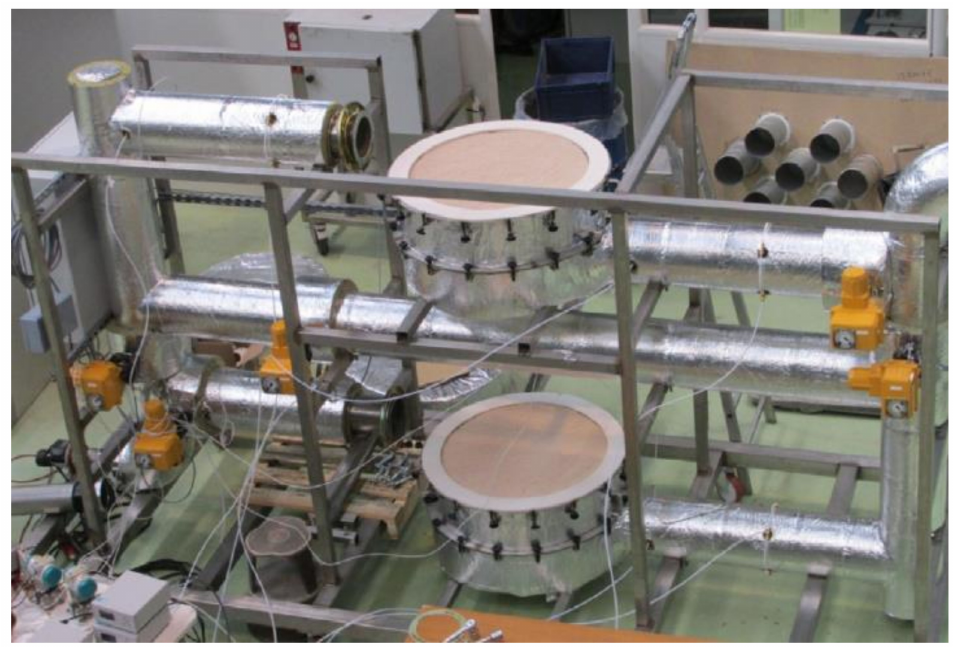
Figure 21. Developed sorption heat storage system